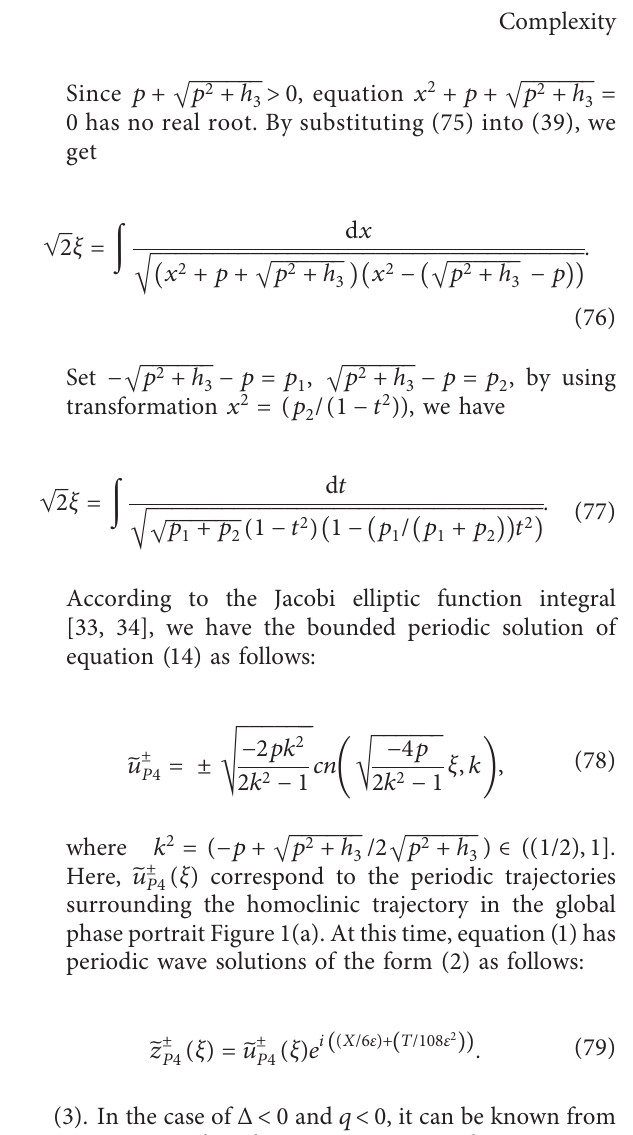
Figure 4 that there exist two periodic trajectories centered on P inside the homoclinic trajectories 3 (correspond to the periodic wave solutions u P u P 4 of equation (14), respectively), and these two trajectories are divided by the line which corre- sponds to the Hamilton energy h